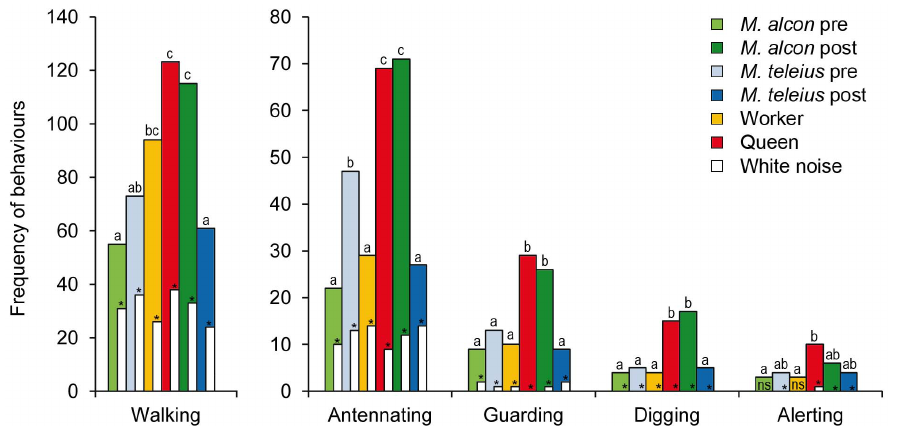
Figure 4. Worker ant reactions to sound stimuli and white noise. When the sound stimuli (color bars) were played simultaneously against the white noise (white bars), they always elicited higher behavioural responses on worker ants (experimental setup Type 1). Comparing the sound stimuli, we found that stridulations produced by queens caused stronger reactions in M. scabrinodis ants than those emitted by workers (red vs . yellow bars). Workers reacted more frequently to sounds produced by M. alcon integrated larvae than those emitted by M. alcon pre-adoption caterpillars (dark green vs . pale green) while on the contrary, the sounds emitted by M. teleius pre-adoption larvae caused more frequent reactions in workers than those produced by post-adoption larvae (light blue vs . dark blue) significantly for ‘‘antennating’’. Different letters indicate significantly different behavioural responses elicited by sound stimuli (Chi square Yates’ correction). Significantly (p , 0.05) different behavioural frequencies between white noises and sound stimuli are indicated by asterisks. ns = statistically not